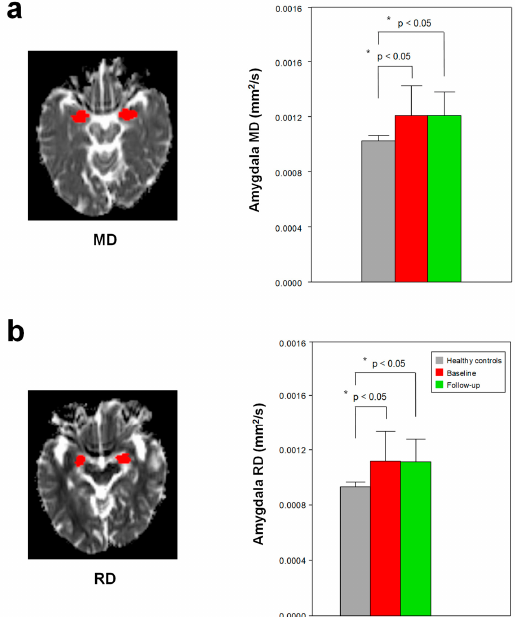
Figure 4. The higher mean diffusivity (MD) ( a ) and radial diffusivity (RD) ( b ) in the amygdala in the patients with early AD compared to those in the healthy controls (Bonferroni-corrected, p < 0.05). None of the other 10 ROIs showed significant differences in the DTI scalars between the healthy controls and the patients with early AD. In addition, no significant differences were found between the patients with early AD and the treated patients in the 11 ROIs. Red in the left figure, the amyg- dala ROI. * Meets Bonferroni-corrected significance level ( p < 0.05).